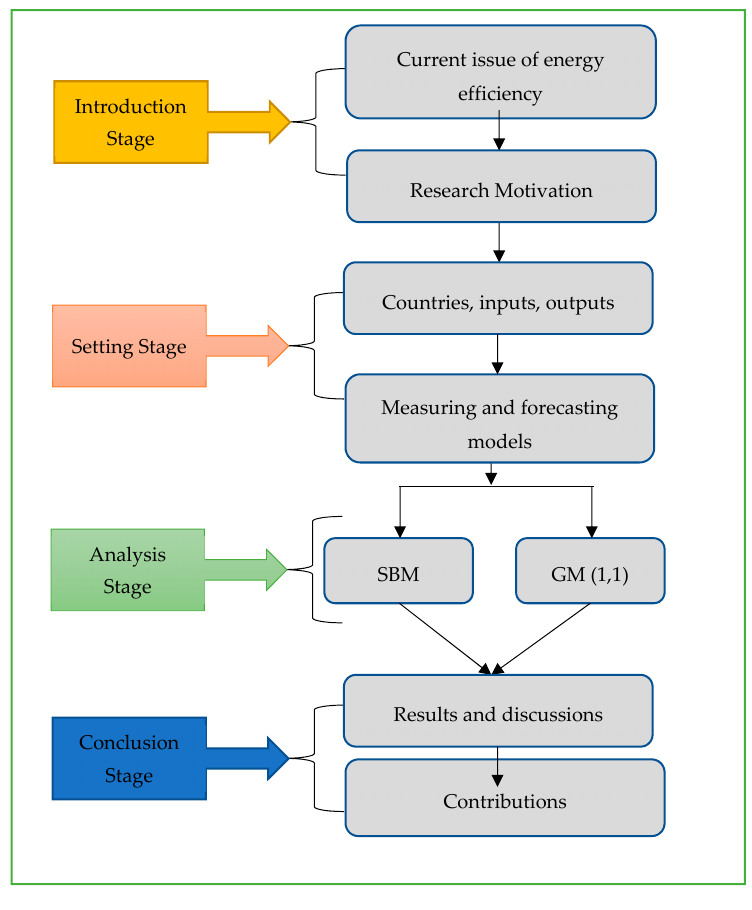
Figure 1. Research Figure 1. Research flow.